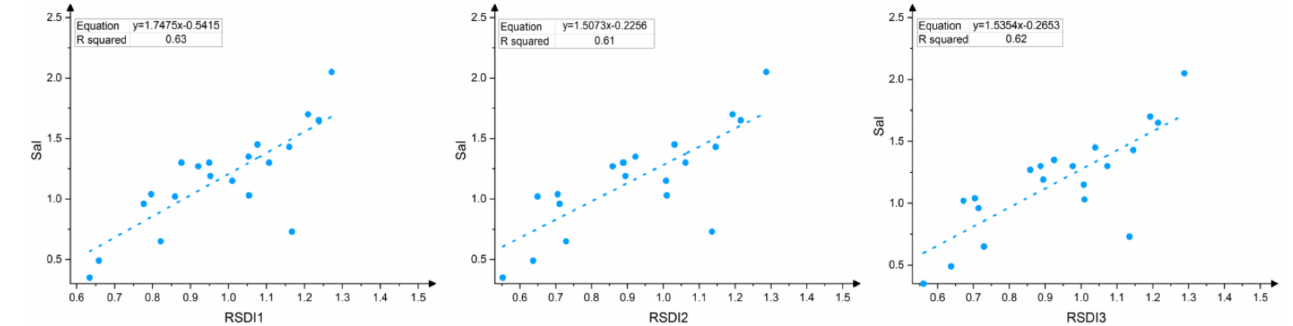
Figure 12. Accuracy comparison between the RSDI1, RSDI2, and RSDI3 models. Using the RSDI models (RSDI1, RSDI2, and RSDI3), information on salinization in the Keriya Oasis was calculated. To distinguish different soil salinity levels better, Landsat 8 (Figure 1e) and OvitalMap were used as reference images. Additionally, based on the fieldwork and previous research [32,53], each salinity index was divided into three categories: a salinity index of 0.8 < RSDI < 1.0 indicated slight salinization; a salinity index of 1 < RSDI < 1.2 indicated moderate salinization; a salinity index of 1.2 < RSDI < 1.4 indicated severe salinization. In addition, a salinity index of 0 < RSDI < 0.6 denoted water bodies, and a salinity index of 0.5 < RSDI < 0.8 denoted plant cover. The distribution of different degrees of soil salinization is presented in Figure 13.